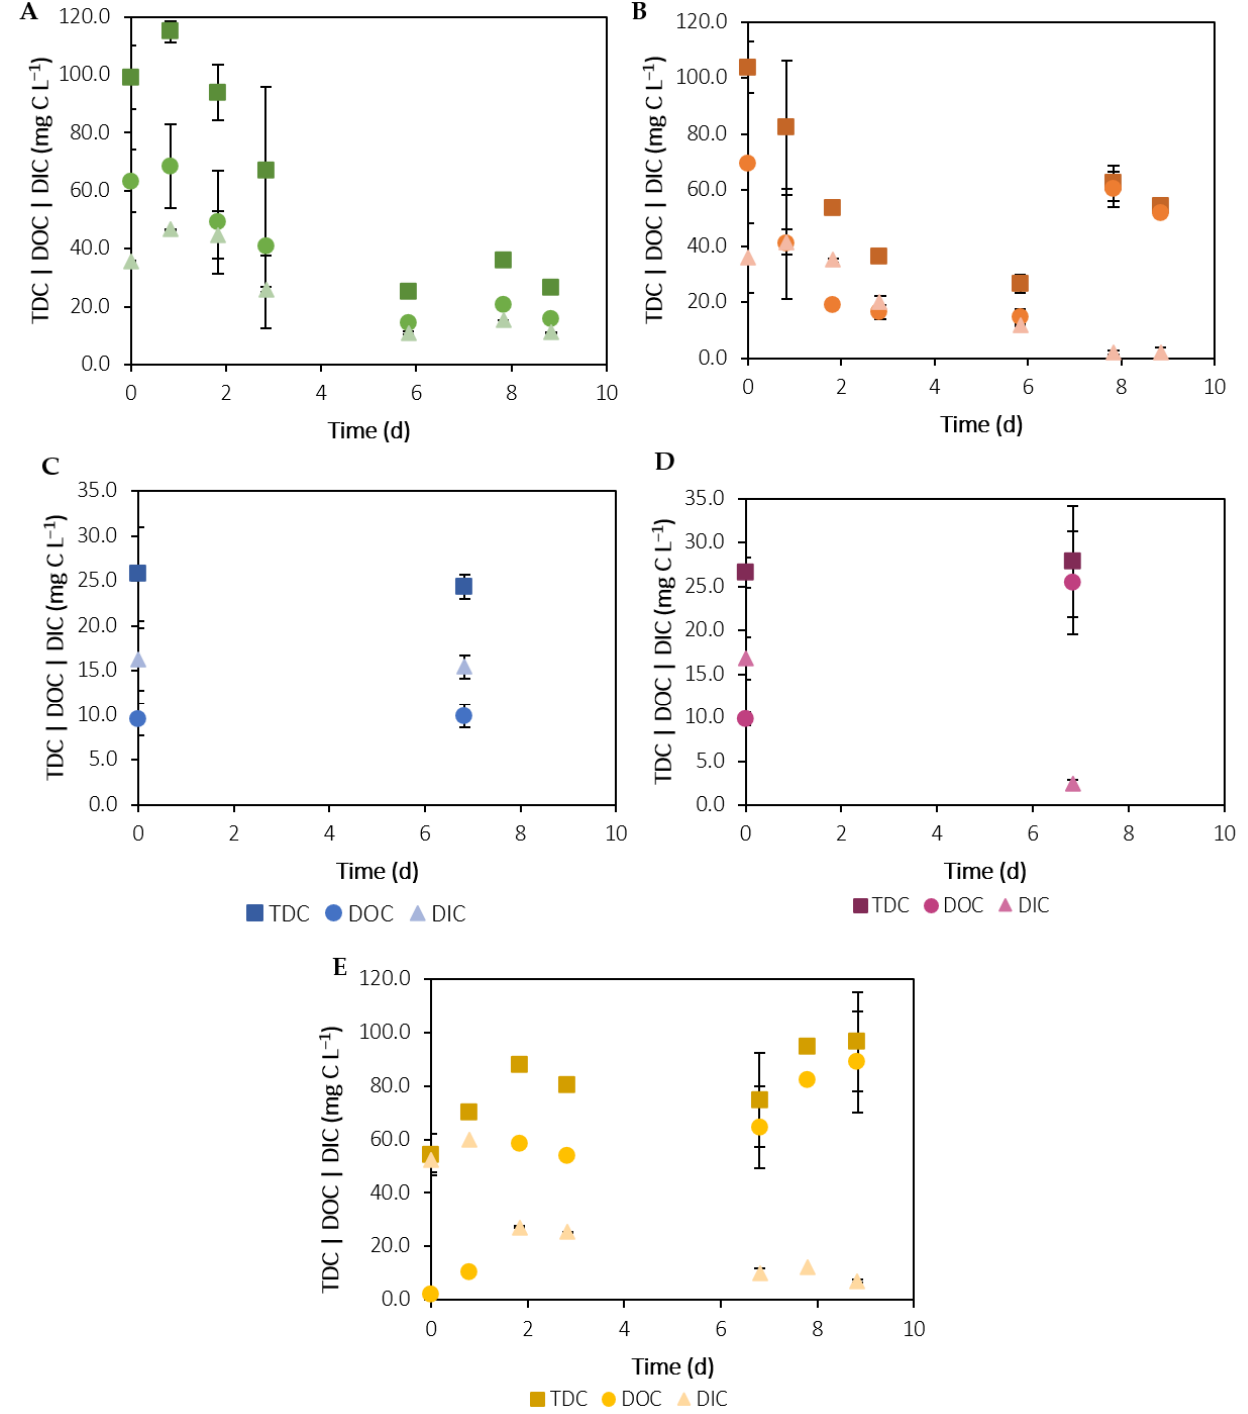
Figure 6. Time-course evolution of TDC, DOC and DIC in assays with C-PE ( A ), PE ( B ), C-SE ( C ), SE ( D ) and C+ ( E ). Error bars correspond to the standard deviation of the mean obtained from two independent experiments.